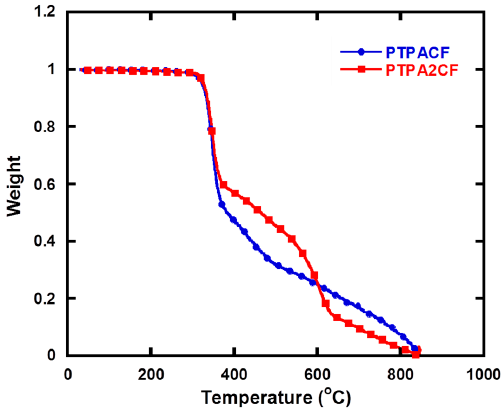
Figure 2. Thermal gravimetric analysis curves of the PTPACF and PTPA2CF.